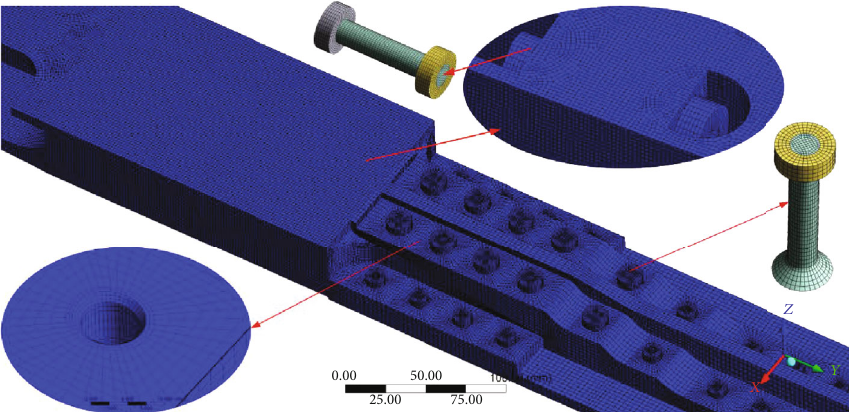
Figure 13: The fi nite element model of the fi tting joint.